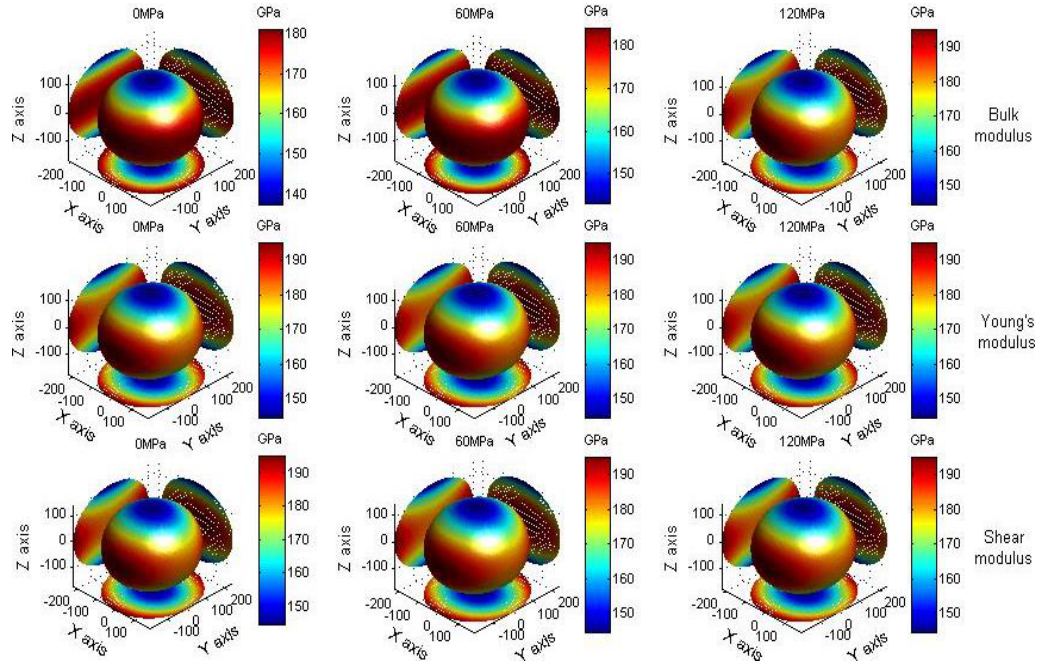
Figure 10. The modulus of anhydrite crystals at pressures of 0 MPa, 60 MPa and 120 MPa.